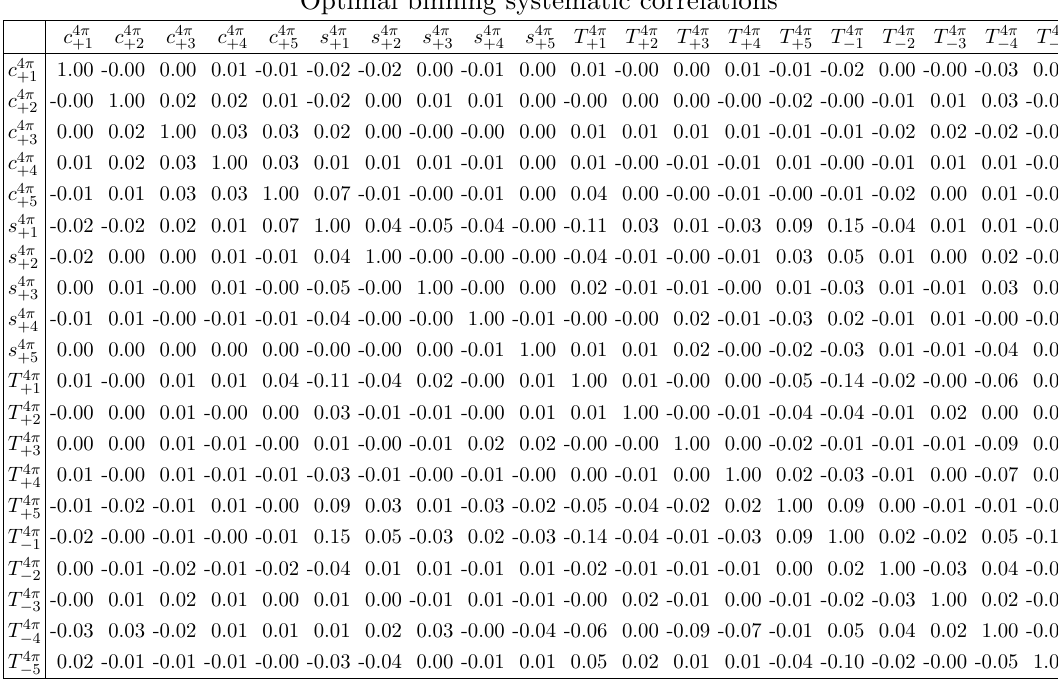
Table 12 . The statistical and systematic correlations between the 4 (cid:25) (cid:6) hadronic parameters using the Optimal binning scheme with N =